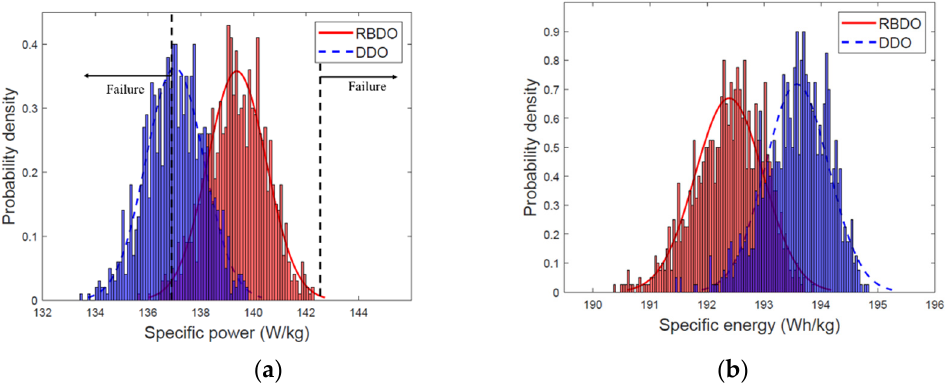
Figure 10. Probability distributions of designs optimized through reliability-based design optimization (RBDO) and deterministic design optimization (DDO) ( a ) specific power; ( b ) specific energy. Table 5. Comparison of design variables and probability of failure between the reliability-based design optimization (RBDO) and deterministic design optimization (DDO).